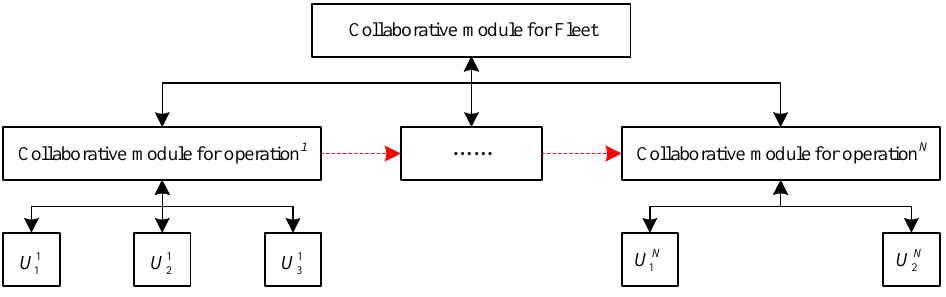
Figure 8. Module structure of the collaborative operating system for fleet management.